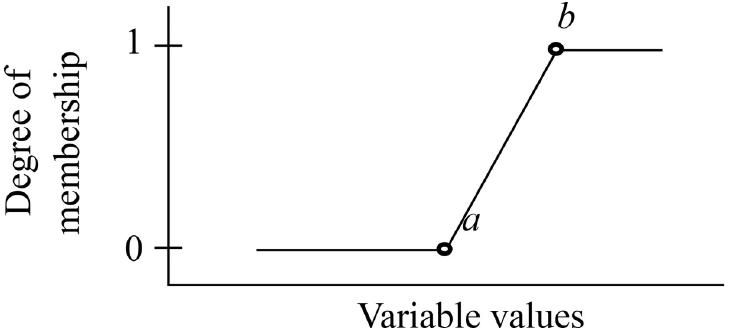
Fig 7. The half triangular membership function (Left-hand